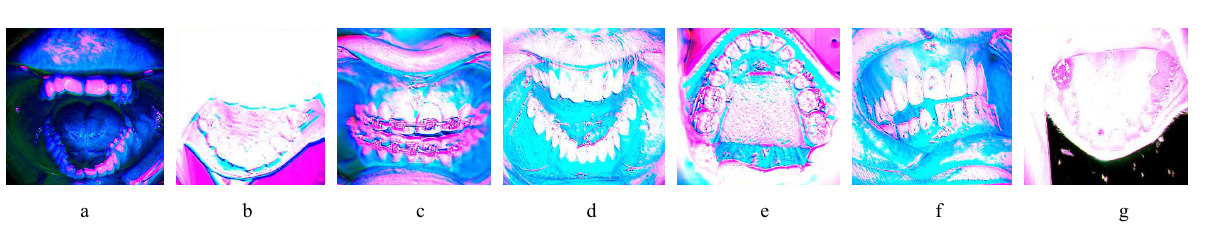
Figure 6. The effects of various color channel-based distortions are shown in ( a – g ) for RGB space, handled by the proposed strategy to produce a clean